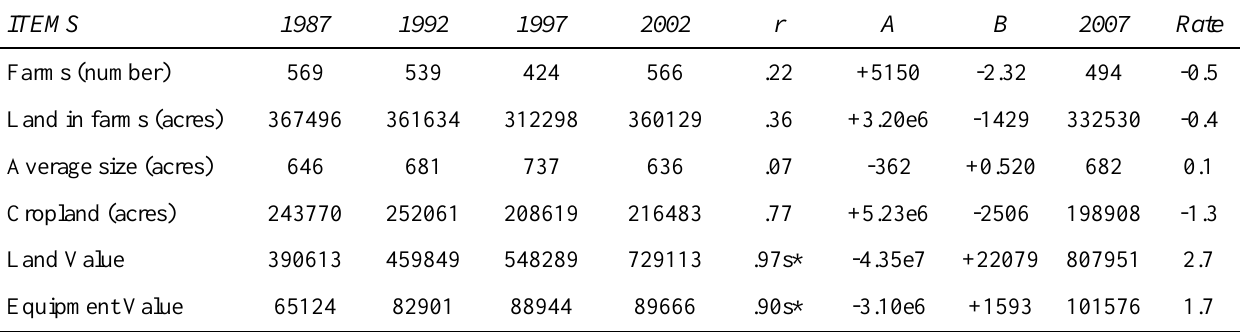
Table 2f: Yazoo County Regression Analysis